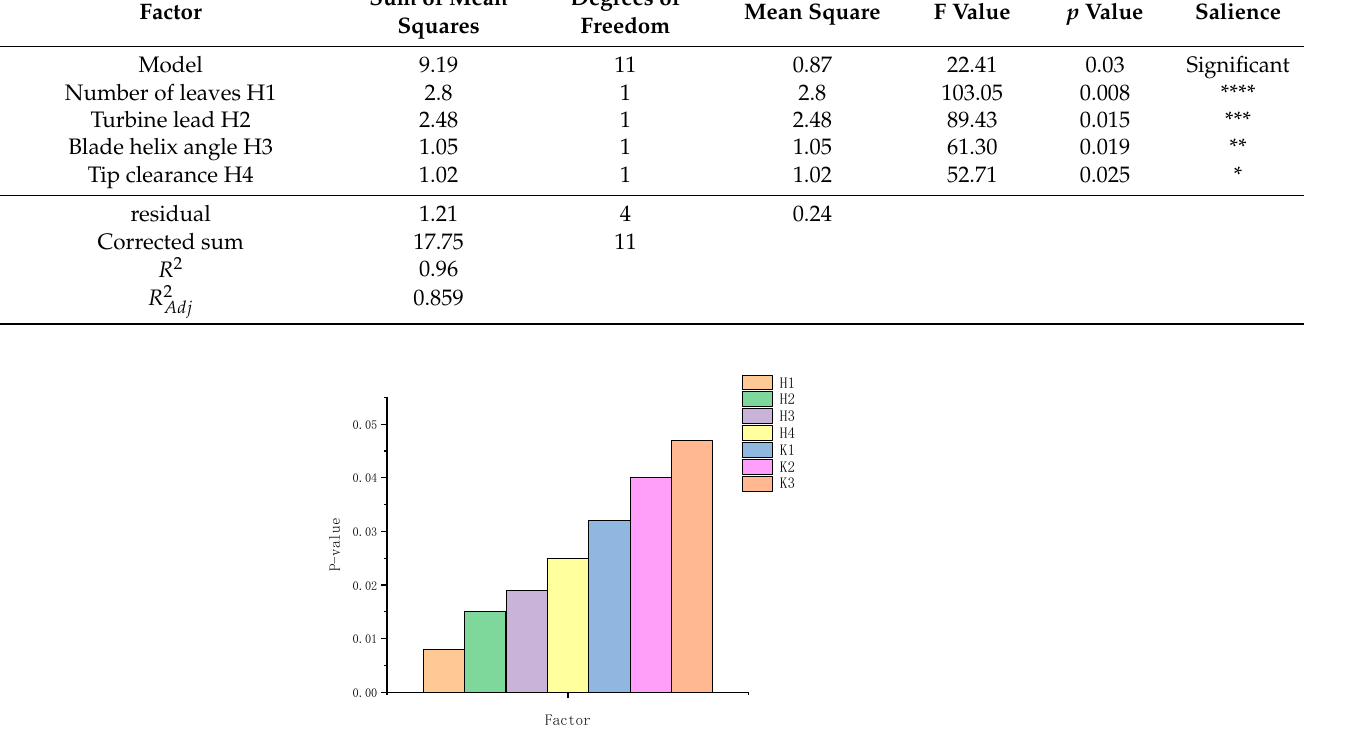
Figure 12. Experimental p value of each factor.